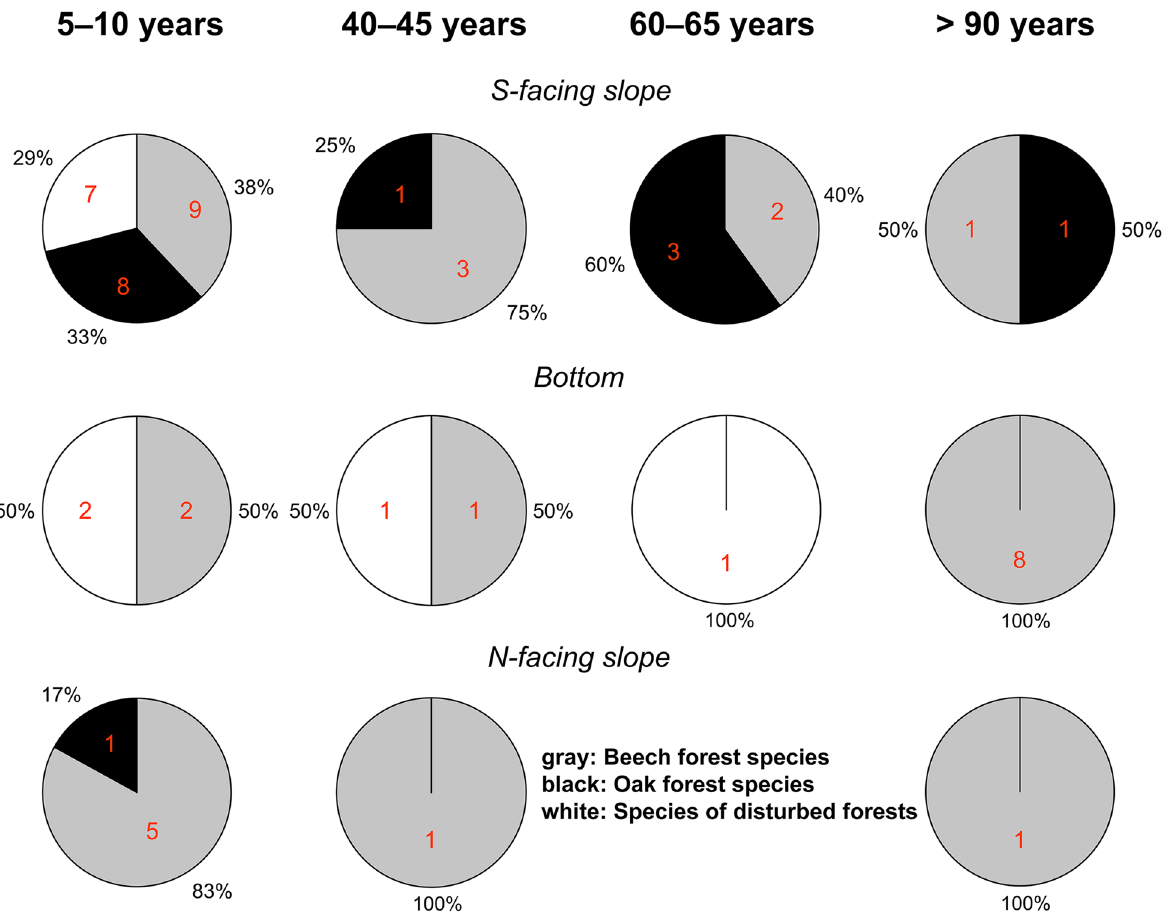
Fig. 2 Number (in red) and proportion of diagnostic species (beech forest species, oak forest species, and species of disturbed forests) in the plots of topographic positions in dolines (south-facing slope, bottom, and north-facing slope) covered with different forest age classes (class 1: 5–10-year-old forest stands with mature forest patches, class 2: 40–45-year-old forests, class 3: 60–65-year-old forests, and class 4: more than 90-year-old forests) (see Table